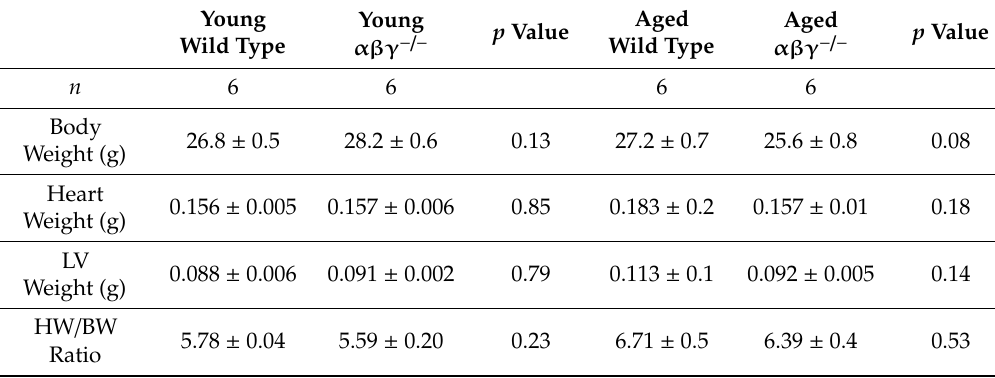
Table 1. Comparison of morphometric parameters between αβγ − / − and wild-type control animals for both young and aged groups. Means ± S.E.M were compared with Mann–Whitney U rank test.